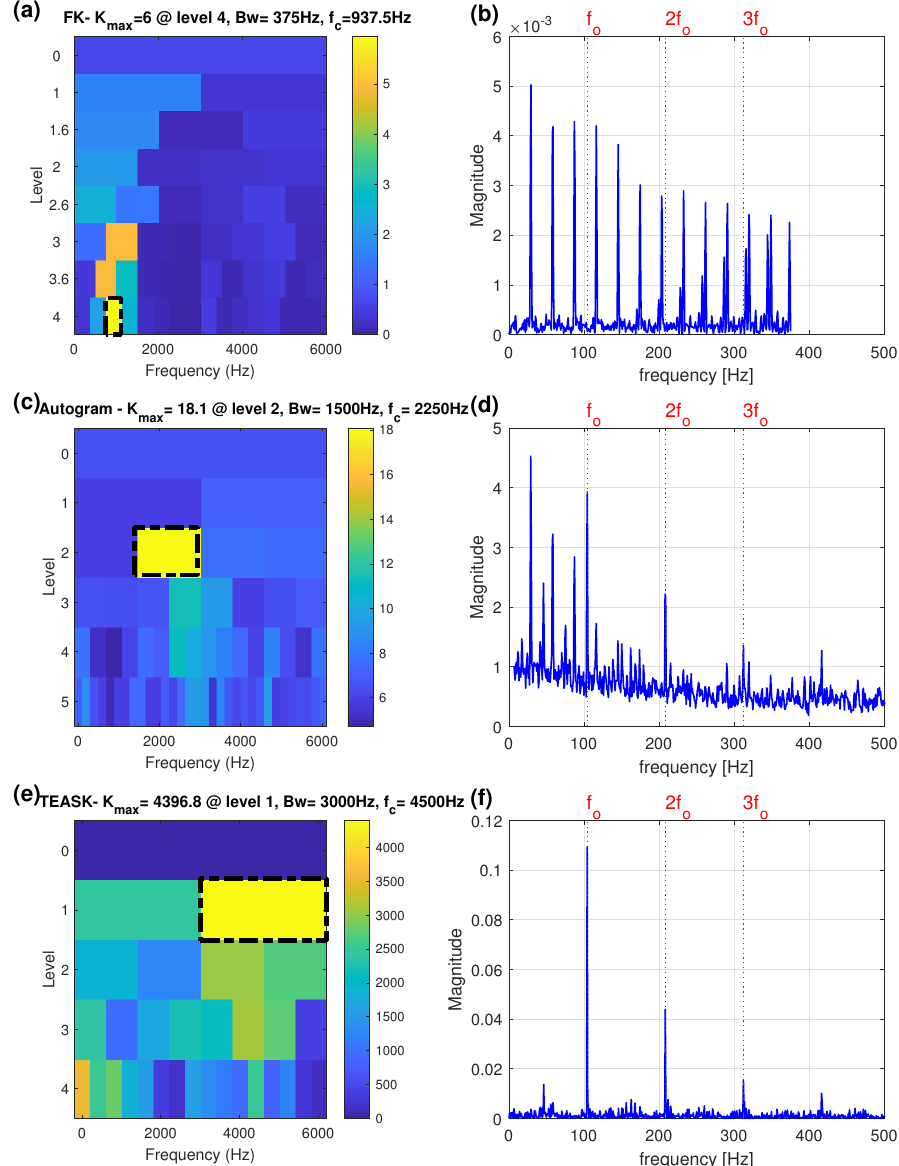
Figure 7. Faulty outer-race bearing under full-load: ( a ) the FK; ( b ) the SES obtained by the node with highest kurtosis of the FK; ( c ) the Autogram; ( d ) the combined SES obtained by the node with highest kurtosis of the Autogram; ( e ) the TEASK; ( f ) the TEPS obtained from the node with highest kurtosis of the TEASK. (Red dotted lines: outer-race frequency component of 104 Hz ( f o ) and its harmonics; black dash-dot rectangle indicates the optimal frequency